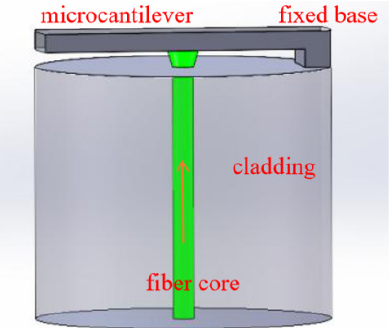
Figure 1. The configuration of an optical fiber microcantilever sensor.